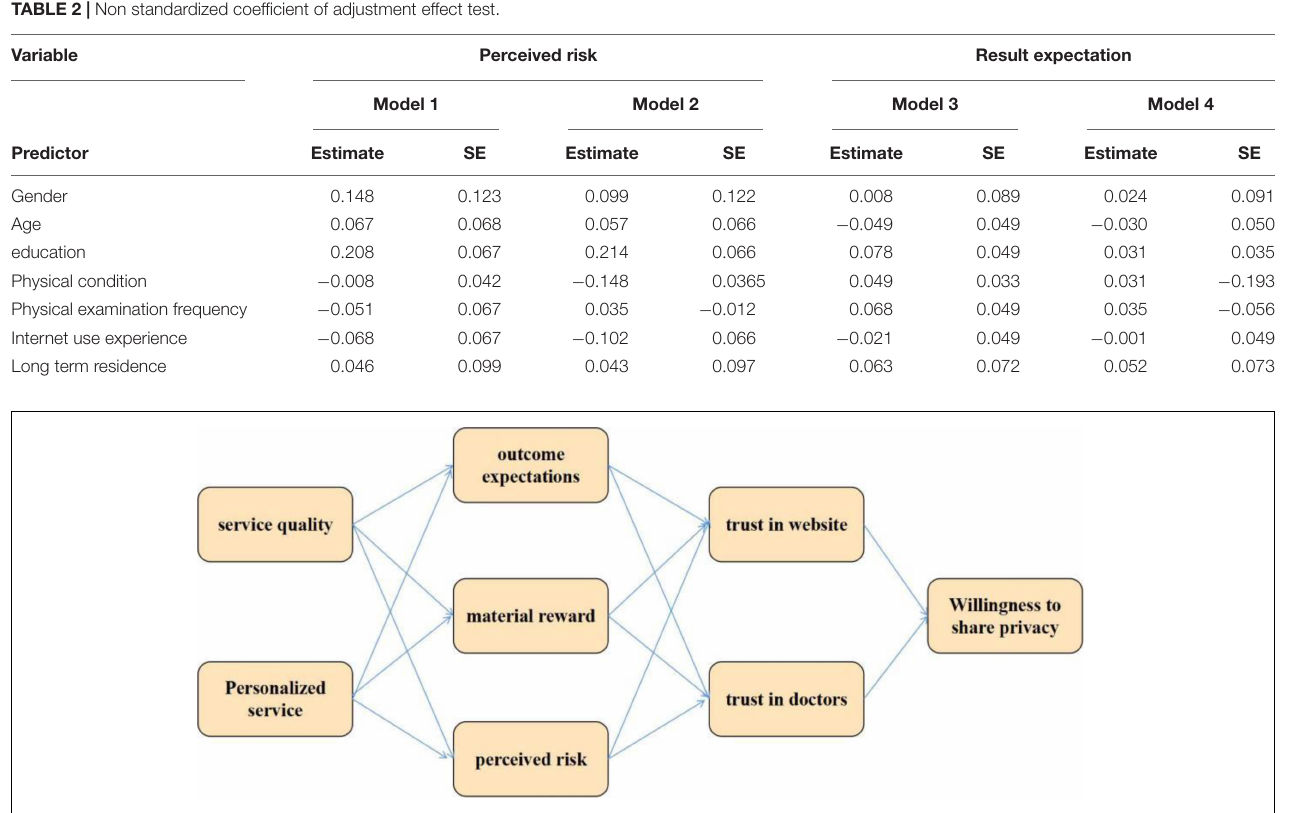
FIGURE 8 | Non standardized path coefficient